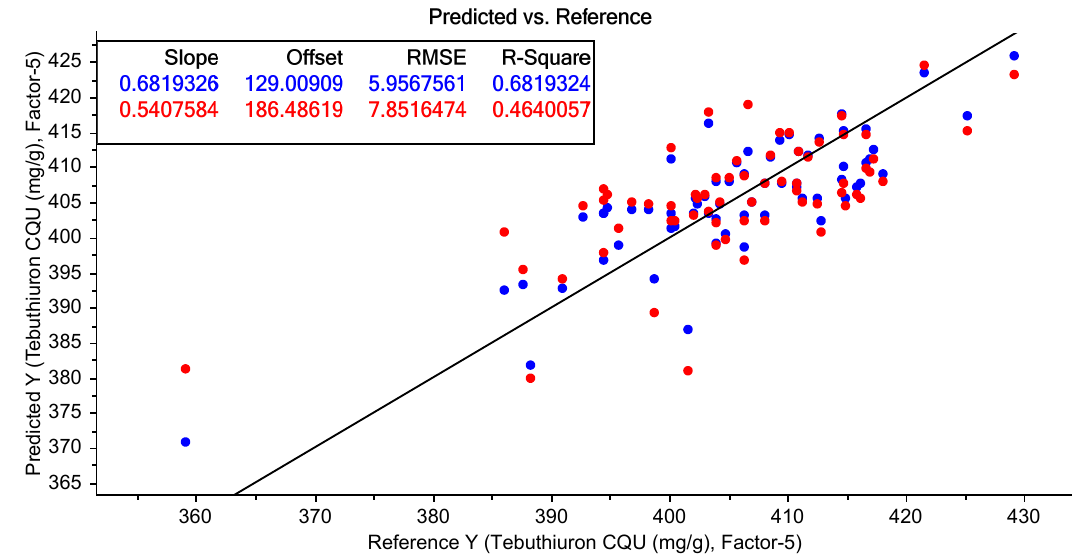
Figure 14. The results of the best-performing PLSR model for the prediction of tebuthiuron content using the benchtop NIR spectra collected from the Regain400 samples (using 2d11 pre-processing). The blue points show the model calibration, while the red points show the model cross-validation.